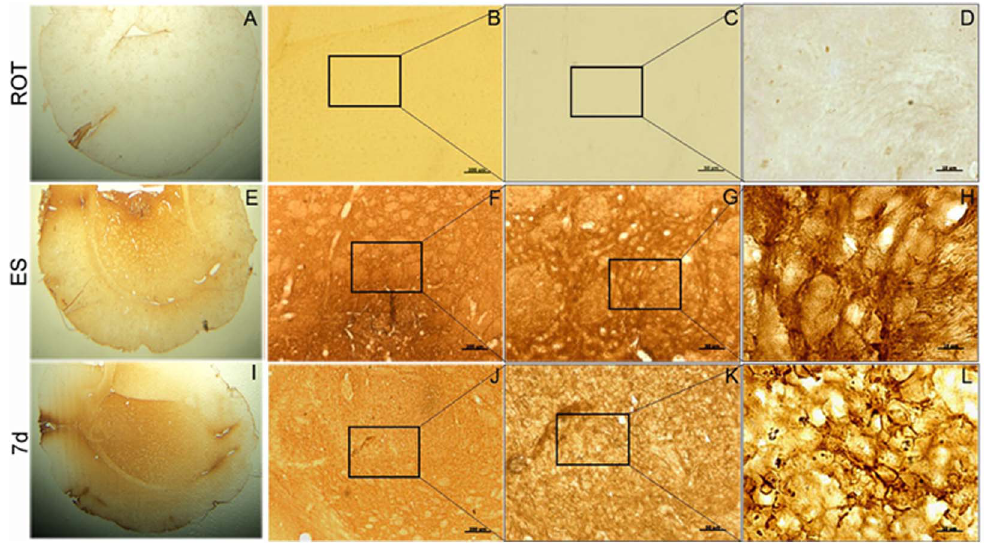
Figure 10. Microglial immunorectivity in striatal grafts. Ipsilateral striatum of sham (A–D), ES (E–H) or 7 days differentiated cells (I–L), transplanted groups were stained for CD11b immunoreactivity. No immune-staining for CD11b was detectable in vehicle, without any cells infused striatum (see A–D). Increased immunostaining for the microglial marker, CD11b is seen only in the ES (E–H) and 7 d cells (I–L) grafted striata. Each figure in CGK and D,H,L is the magnified versions of the marked regions of the figure from the previous figure in the same lane. Magnifications are as